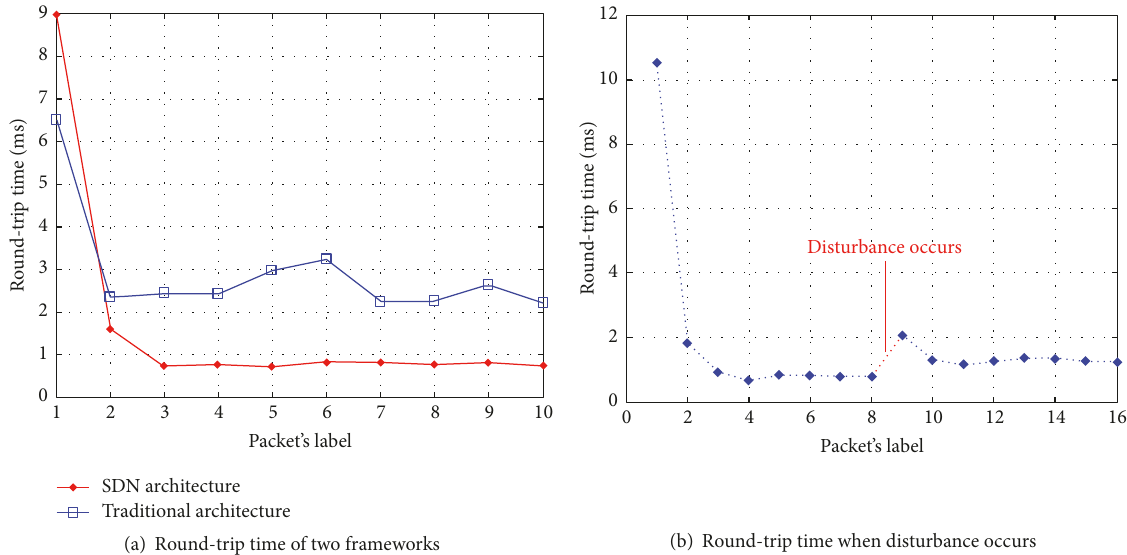
Figure 9: Round-trip time of SDN-enabled